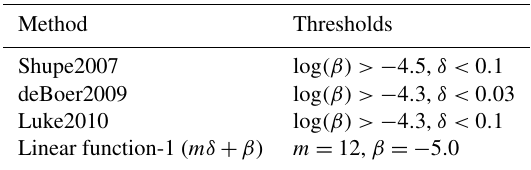
Table 1. Published thresholds of β and δ for lidar-based liquid clas- sification and the linear-1 function threshold used for the ACCEPT data